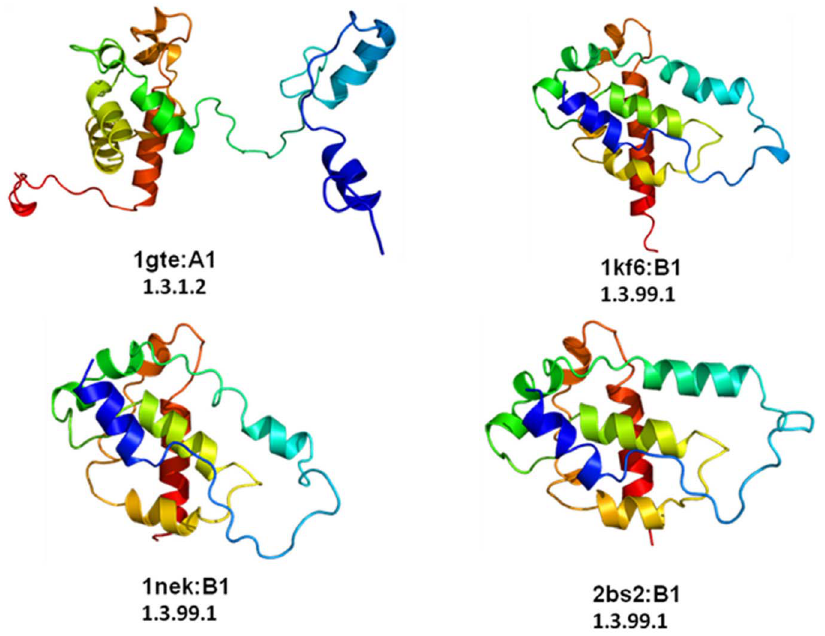
Figure 6. Structural view of the four domains of alpha-helical ferredoxin superfamily. 1gte:A1 is the structurally deviant member of the superfamily with different E.C. number. It has slightly elongated N-terminal tail part. All the other three domains superimpose well with less than 3A˚